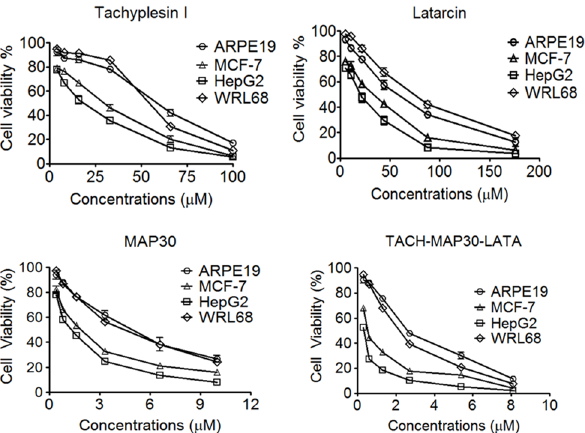
Fig 4. The anti-proliferative activity of the peptides. The individual components of the fusion protein (TACH, LATA and MAP30) showed higher inhibition against cancer cells compared with normal cells in an overall dose range of 0 – 200 μ M based on the maximal toxic concentration of each peptide. The 50% cytotoxic concentration (CC 50 ) of the peptide-fusion protein (TACH- MAP30-LATA) towards HepG2 (0.35 ± 0.1 μ M) and MCF-7 (0.58 ± 0.1 μ M) was significantly lower than WRL68 (1.83 ± 0.2 μ M) and ARPE19 (2.5 ± 0.1 μ M). Two Way-ANOVA, P < 0.001.